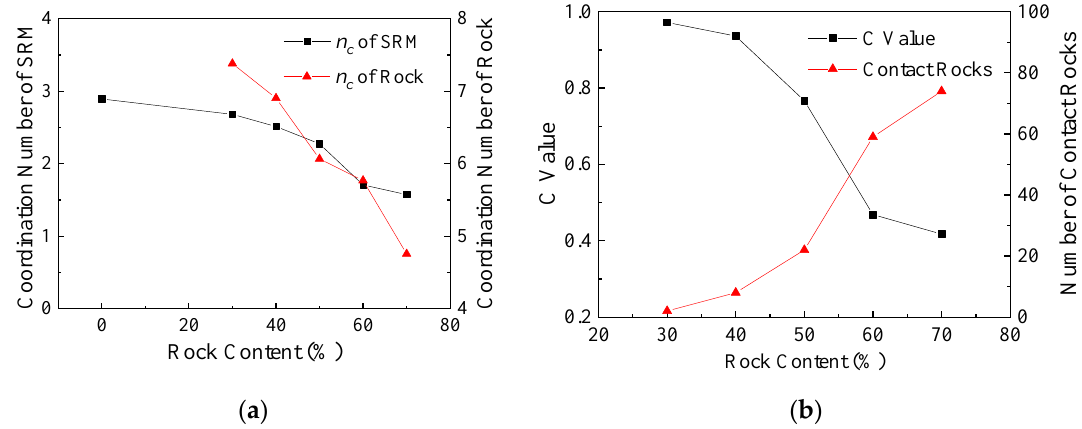
Figure 7. Contact characteristics of numerical specimens at 40 kPa cell pressure: ( a ) coordination number ( n c ); ( b ) C value.